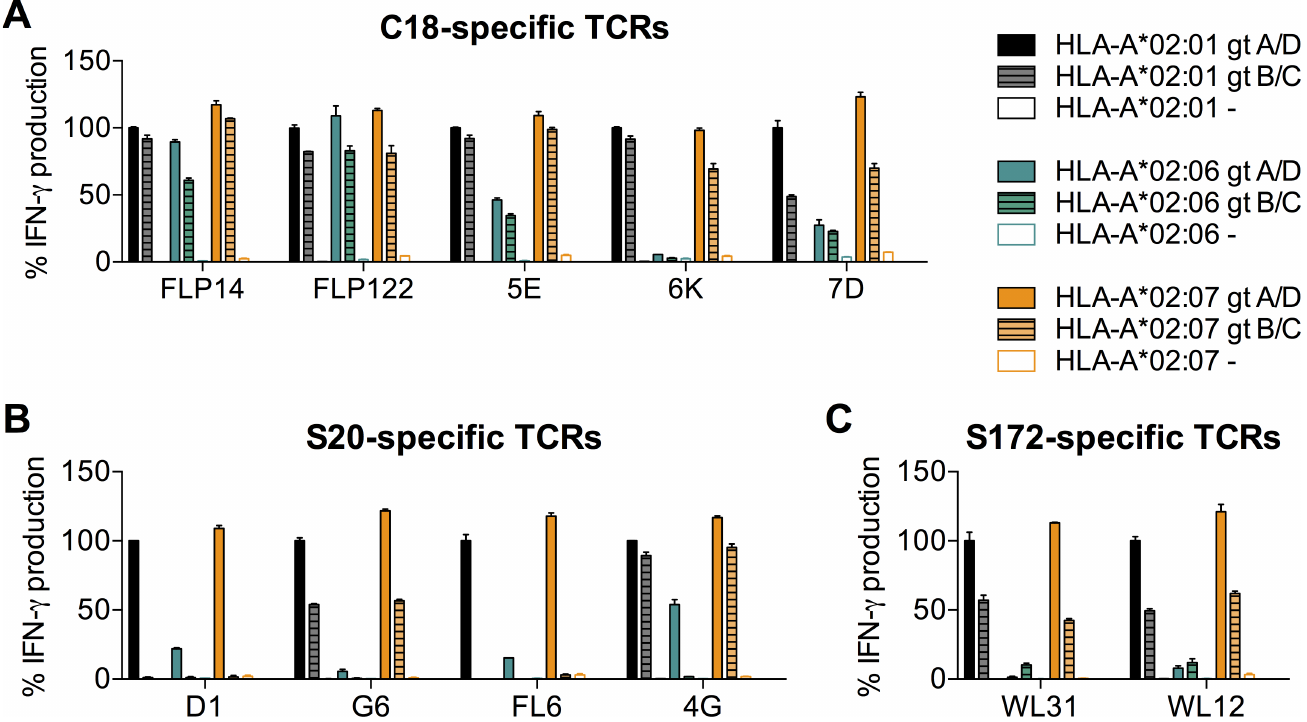
Fig 5. Recognition of different HBV genotypes. LCL with varyingHLA-A * 02subtypes were loadedwith HBV peptides(1 μ M) and co-cultured with T cells (CD8 + and CD4 + combined)transduced with C18-specific (A), S20-specific(B) or S172-specific (C) TCRs. T-cell activationwas determined by IFN- γ secretionmeasuredby ELISA. IFN- γ secretionis shown relativeto that determined upon recognitionof subtype HLA-A * 02:01 loadedwith the respectivegenotypeA/D peptide(set to 100%), becausethis constellation had been used for isolatingthe TCRs. Peptide sequences: C18: HBV gt A/D: FLPSDFFPSV, HBV gt B/C: FLPSDFFPS I ; S20: HBV gt A/D: FLLTRILTI, HBV gt B/C: FLLT K ILTI; S172: HBV gt A/D: WLSLLVPFV, HBV gt B/C: WLSLLV Q FV. Data are presentedas mean values +/- SEM from